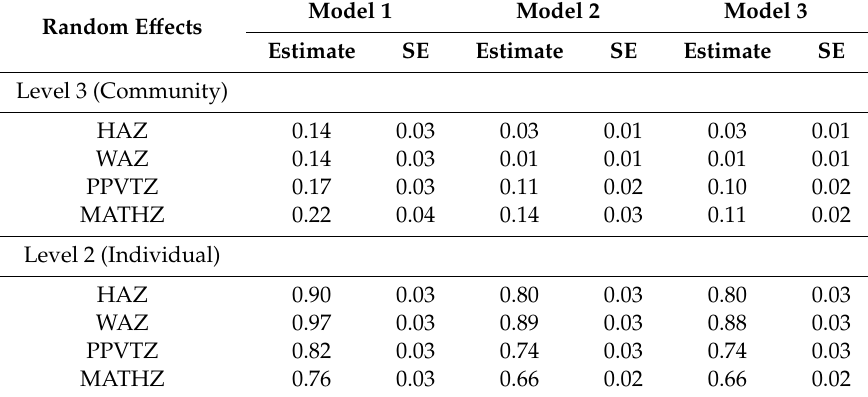
Table 3. Individual- and community-level variance in height-for-age z-score (HAZ), weight-for-age z-score (WAZ), Peabody Picture Vocabulary Test z-score (PPVTZ), and math test z-score (MATHZ).